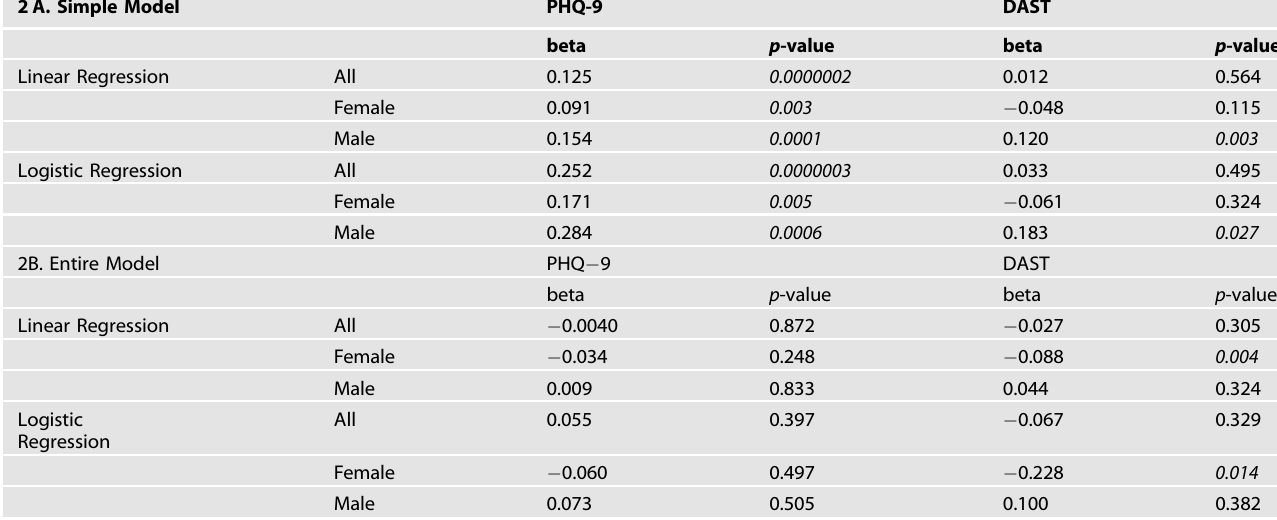
Table 2. Linear and Logistic Regression for Simple and Entire Models and Association with